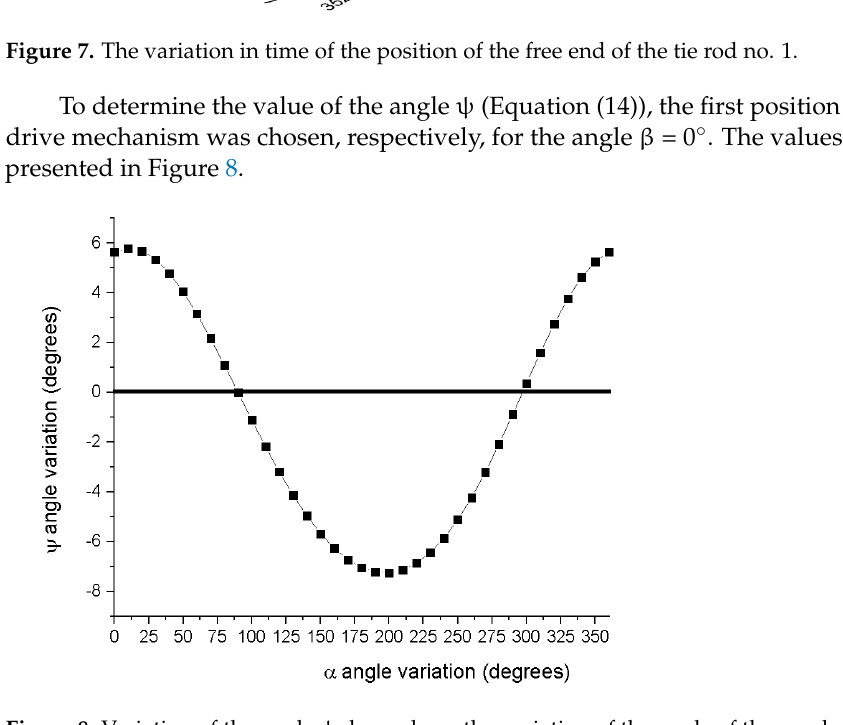
Figure 9. Variation of the angle ψ for different values of the angle β . By analyzing the variation of the angle ψ about the variation of the angle β , it was observed that angle ψ has minimum values for the range of angle β from 0–30°, with a minimum of 13°. Once the value of the angle β was different from this interval, it was found that the angle ψ increased in value, reaching a maximum of 32° for the angle β = − 45°.